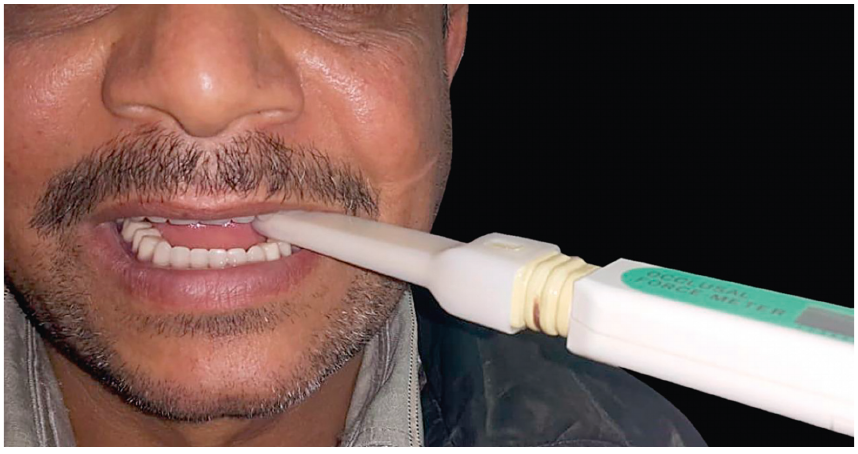
Figure 6: Patient exerts a maximum biting force on the bite force Table 1: Descriptive analysis of measured surface deviations between scanned master casts and scanned overdenture bases fabricated by conventional and CAD/CAM milled techniques.